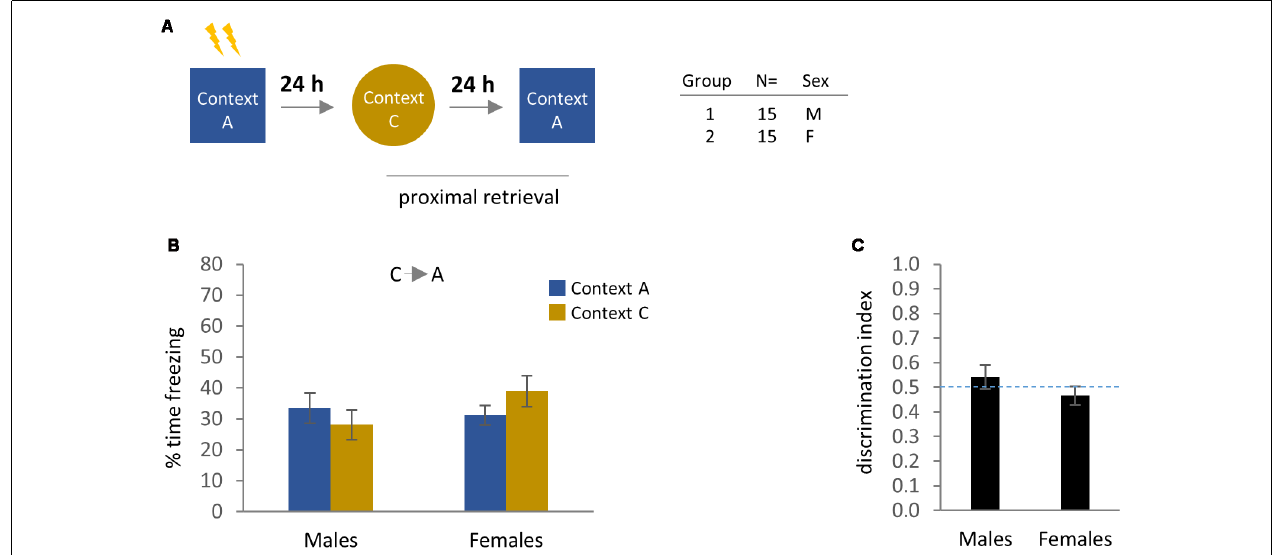
FIGURE 7 | Contextual fear memory and generalization at proximal time-points (C → A test order), in which the metal grid floor of the training context is retained in the otherwise contextually distinct generalization context. (A) Experimental design and cohort information. (B) Comparison of freezing behavior in male and female mice at 24–48 h after conditioning. (C) Discrimination index. Error bars are mean ±